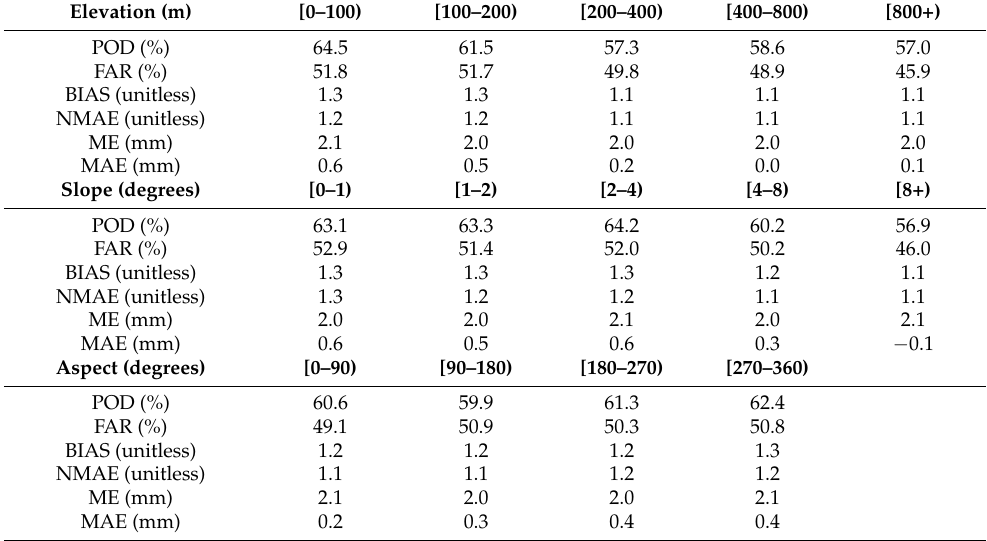
Table 8. Categorical and error statistics for CRRPh v2021 for different bins of elevation, slope, and aspect. Twenty-four-hour, yearly datasets are